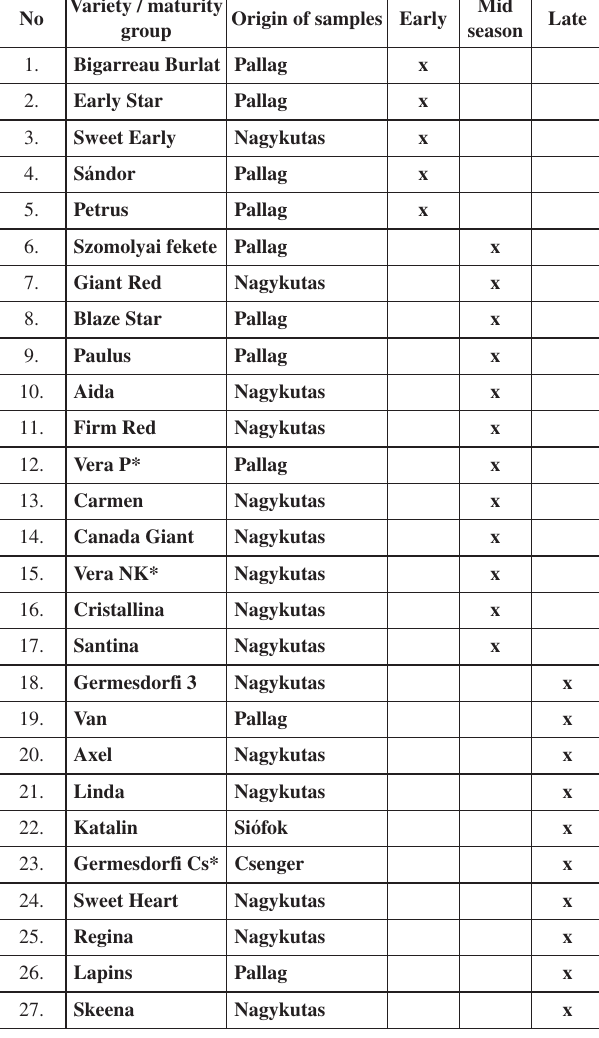
Table 3. Sweet cherry varieties selected for the sensorial